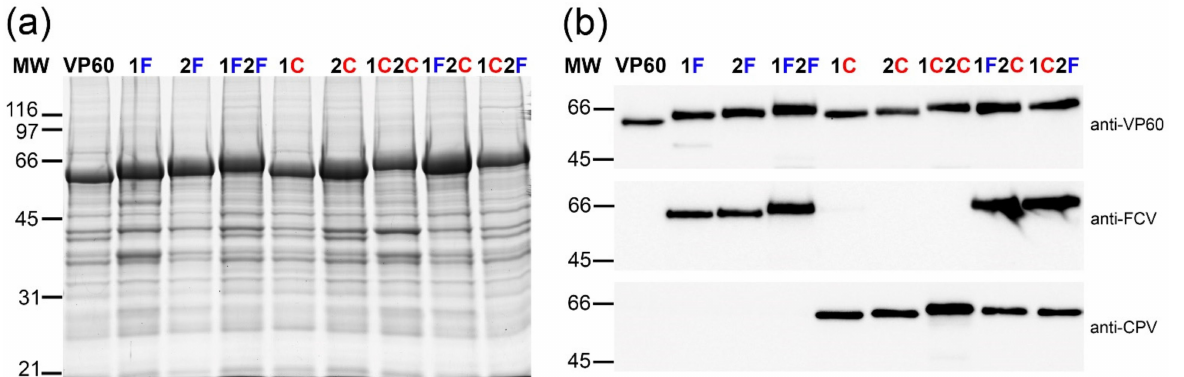
Figure 2. Expression and characterization of RHDV VP60 constructs displaying FCV and CPV target epitopes. ( a ) SDS-PAGE analysis of recombinant baculovirus-infected H5 cell-extracts expressing the indicated constructs. ( b ) Western blots performed using a rabbit hyperimmune serum against RHDV to detect VP60 protein or monoclonal antibodies directed against the FCV and CPV B-cell epitopes, as indicated. The position of molecular weight markers (MW; × 10 3 Da) is shown on the